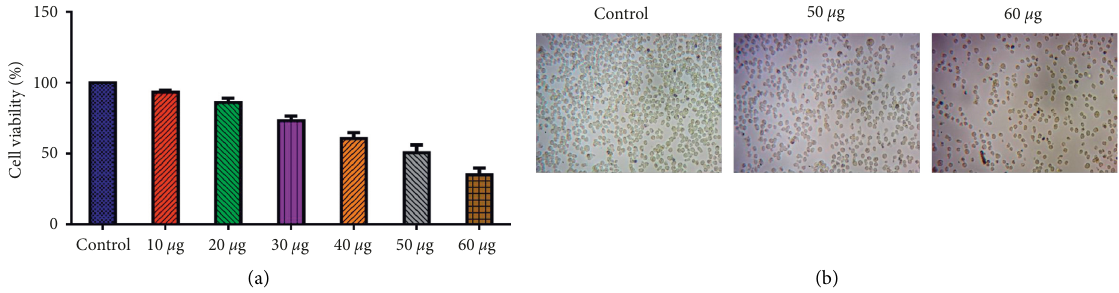
Figure 6: The cytotoxic effect of ZnO-TiO 2 -chitosan-farnesol NCs on MOLT-4 cells. ZnO-TiO 2 -chitosan-farnesol NCs treated in the cells for 24 hours at several concentrations, and the MTT assay employed to calculate the cell viability (a). Morphological changes in MOLT-4 cells after ZnO-TiO 2 -chitosan-farnesol NCs treatment at 50 and 60 μ g/ml concentration for 24h observed under the light microscope at 20 × magnification (b).